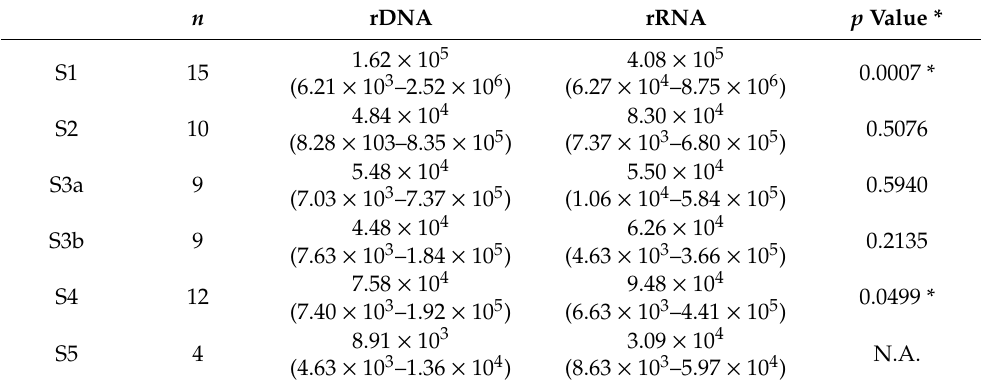
Table 4. Median values (range) of rDNA and rRNA levels in root canal samples with qPCR positive reactions for both methods. Samples were taken after access cavity (S1), root canal preparation